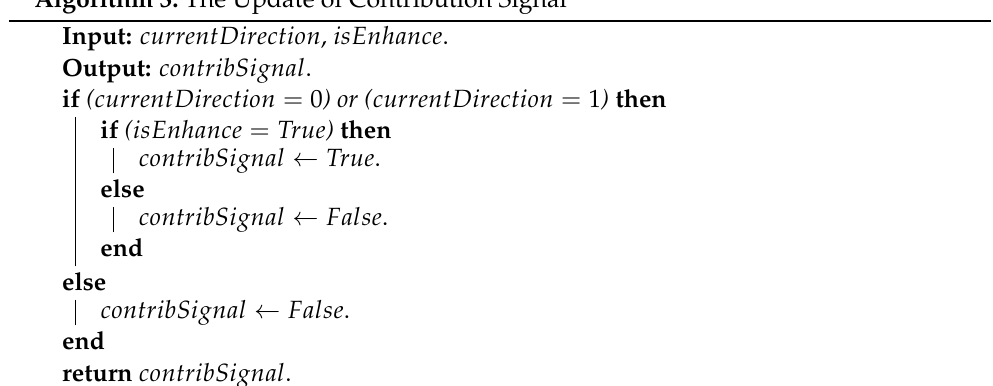
Algorithm 3: The Update of Contribution